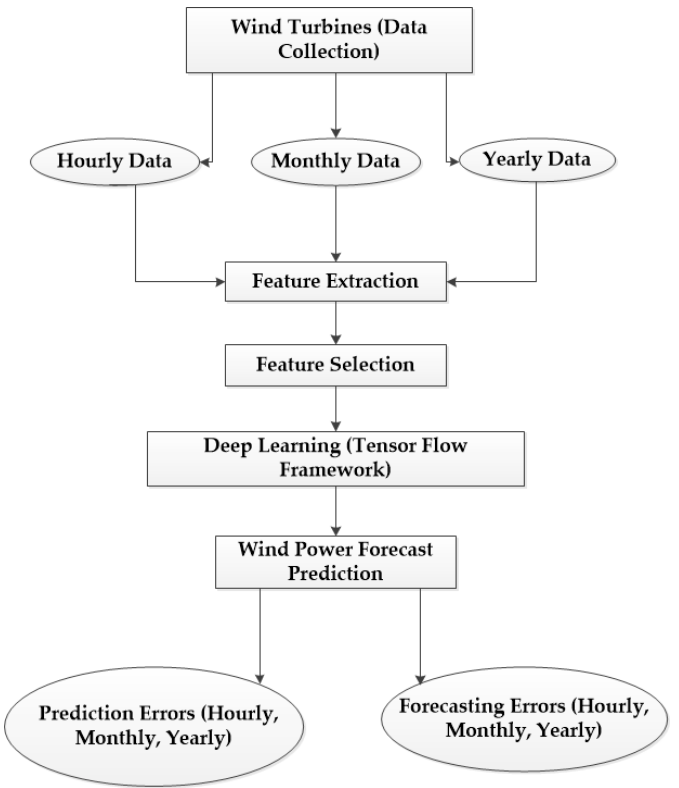
Figure 1. Methodology for wind power forecasting using principal component analysis (PCA) and deep learning.